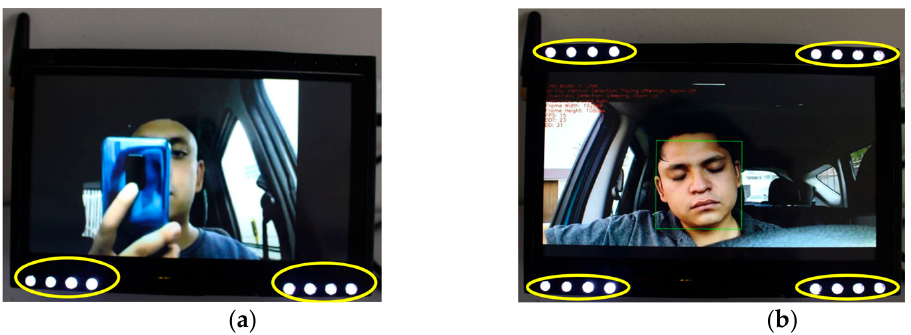
Figure 25. The SOMN_IA is working during driving. The graphical user interface (GUI) shows driver’s face and his state.